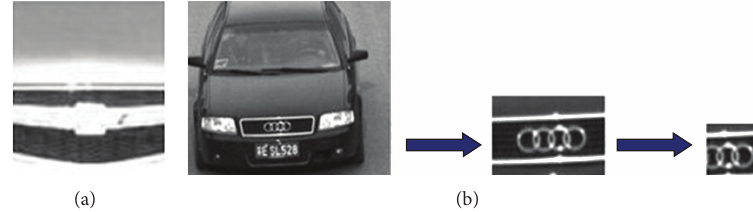
Figure 23: (a) The negative light effect. (b) The rectangular shape of Audi logo.